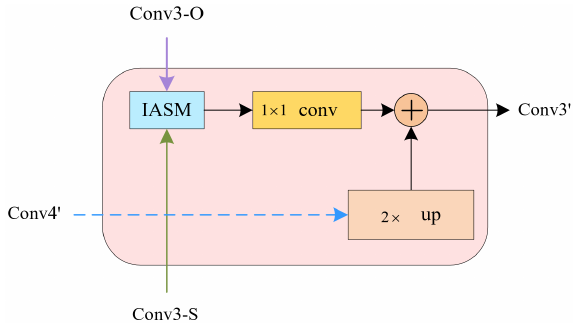
Figure 3. Structure of IASM + Up